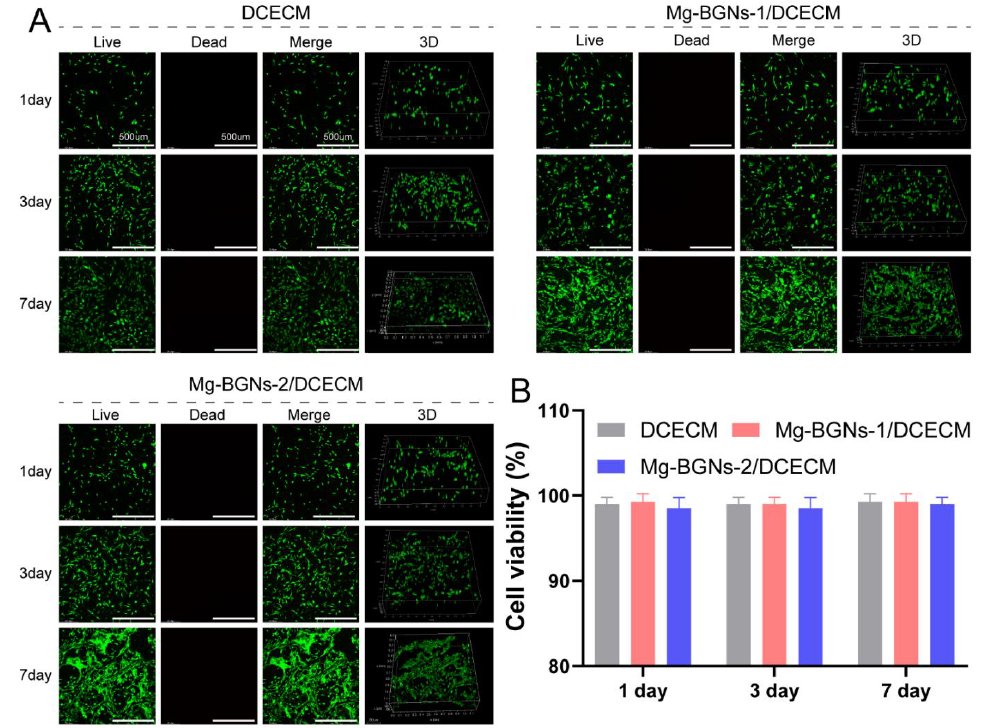
Figure 5. The cell viability analysis of the DCECM, Mg-BGNs-1/DCECM and Mg-BGNs-2/DCECM scaffolds: ( A ) The live/dead staining of bone marrow mesenchymal stem cells (BMSCs) seeded on scaffolds for 1, 3, and 7 days; representa- tive images show live (green) cells, dead (red) cells, and 3D reconstruction images; ( B ) The viability analysis of BMSCs seeded on the DCECM, Mg-BGNs-1/DCECM and Mg-BGNs-2/DCECM scaffolds for 1, 3, and 7 days. Data are expressed as means ± standard